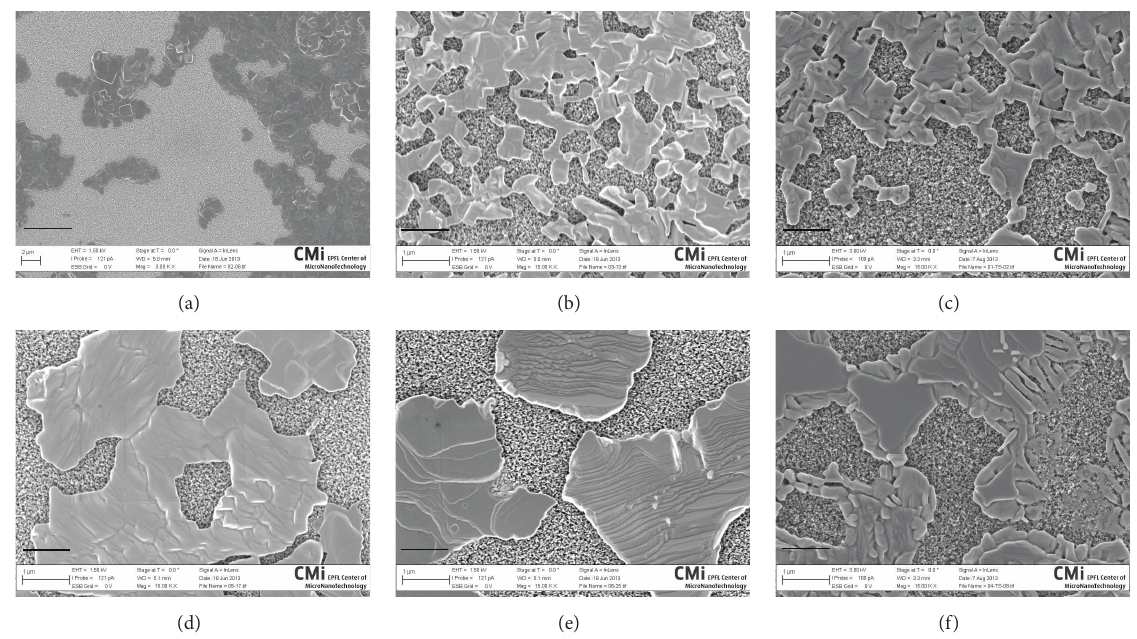
Figure 1: SEM images of perovskite annealed at (a) 60 ∘ C, (b) 80 ∘ C, (c) 100 ∘ C, (d) 120 ∘ C, (e) 150 ∘ C, and (f) 175 ∘ C. Reproduced from [20] with permission from Wiley-VCH.